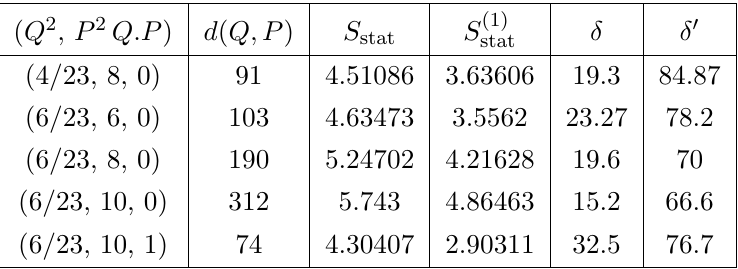
Table 10 . Comparison of the statistical entropy and statistical entropy at one loop for 23A